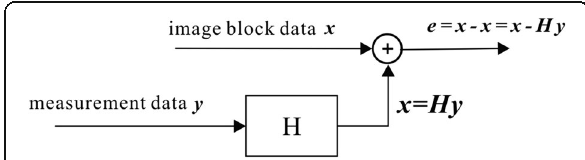
Fig. 3 The principle of the embedded block optimization hierarchy tree